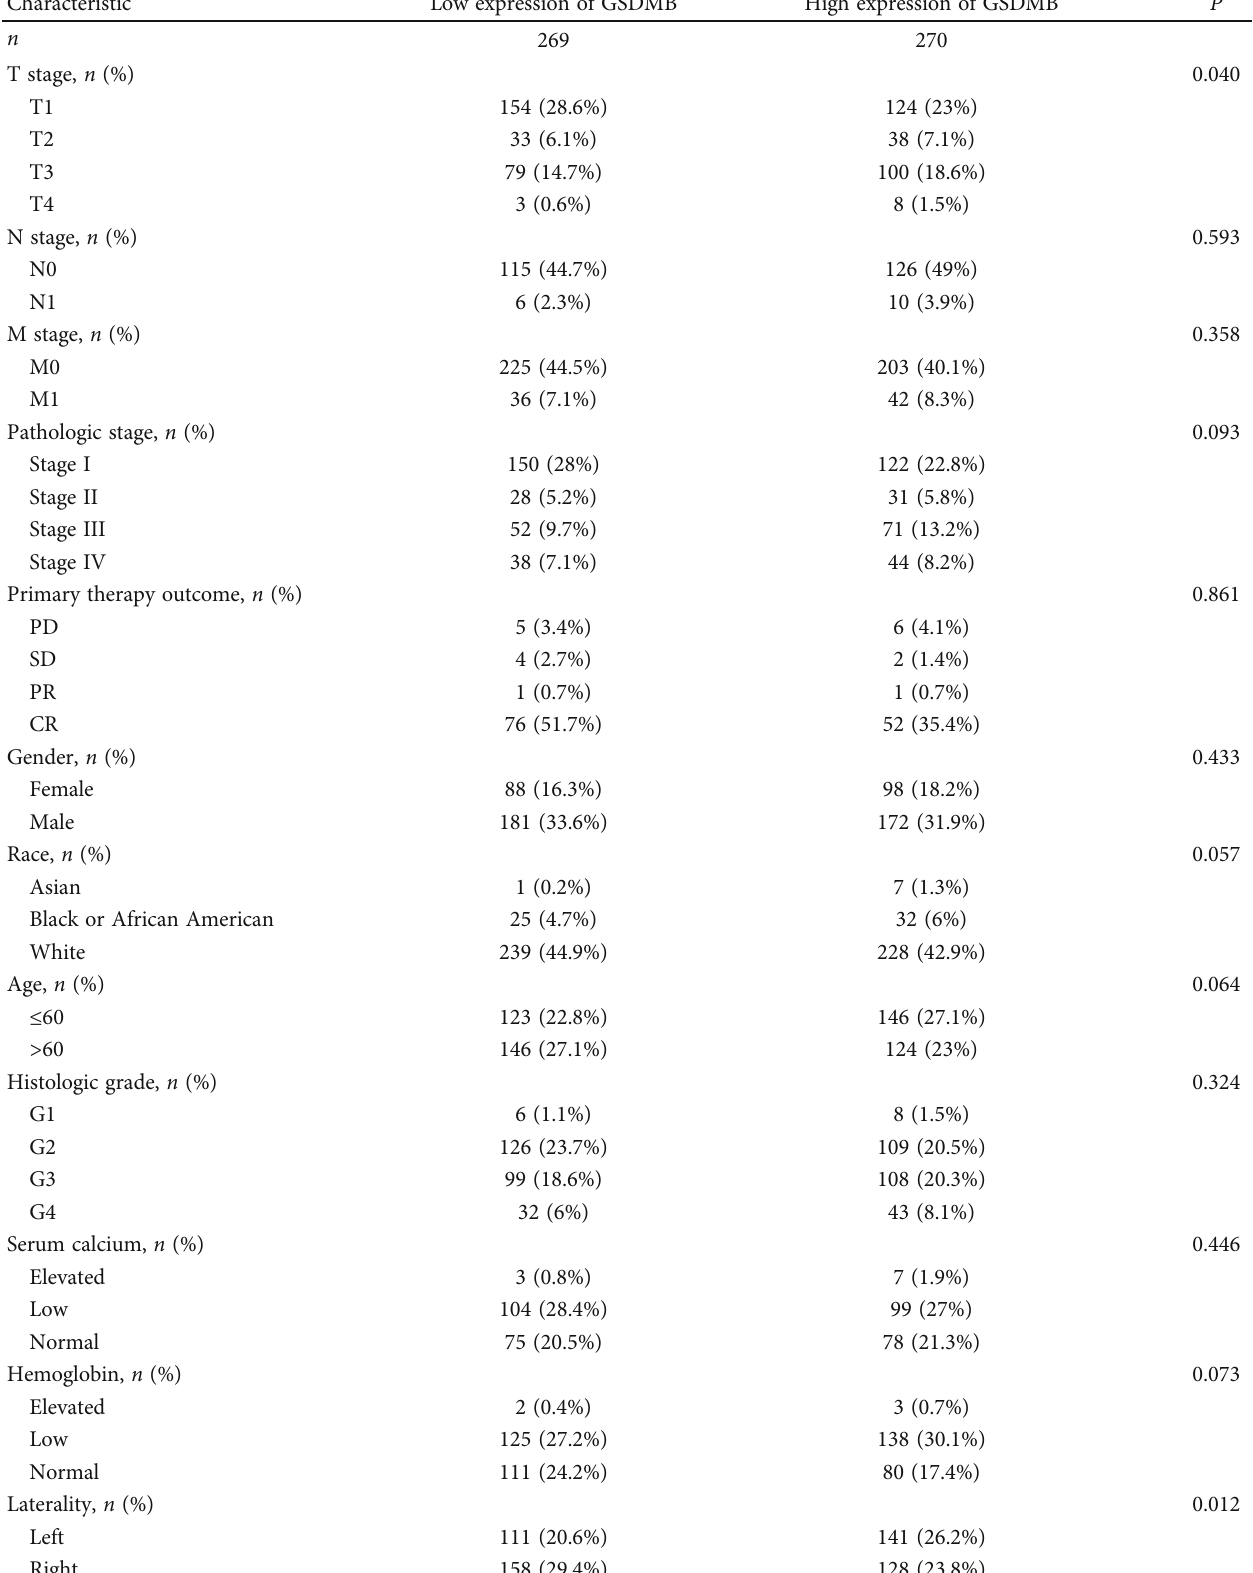
Table 1: The clinical characteristics of ccRCC patients between the high GSDMB expression group and low expression group.